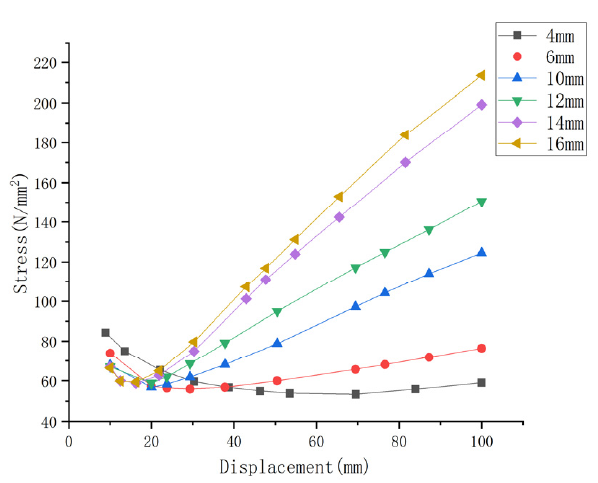
Figure 15. Stress history at B f .